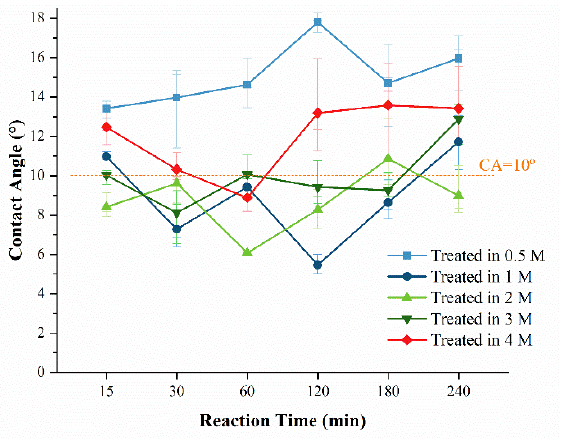
Figure 5. The influence of the fabrication parameters on CA of the electrodes; CA < 10° is described as super-hydrophilic.